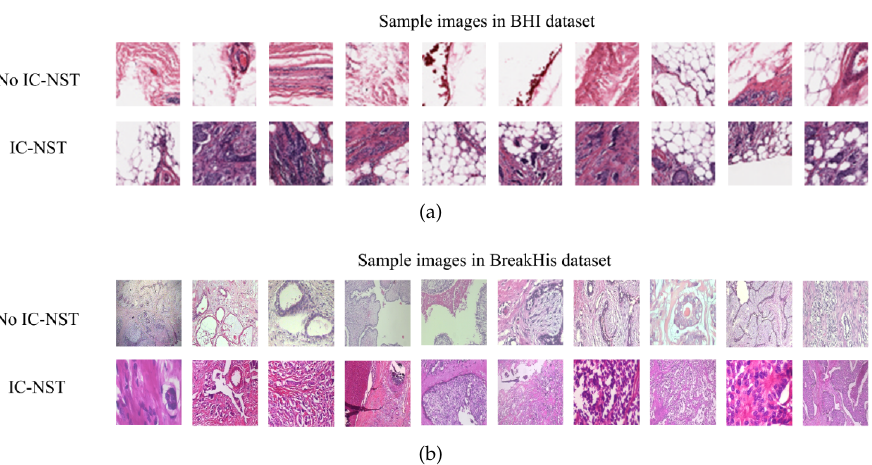
Figure 2. Patches available in the BHI dataset.